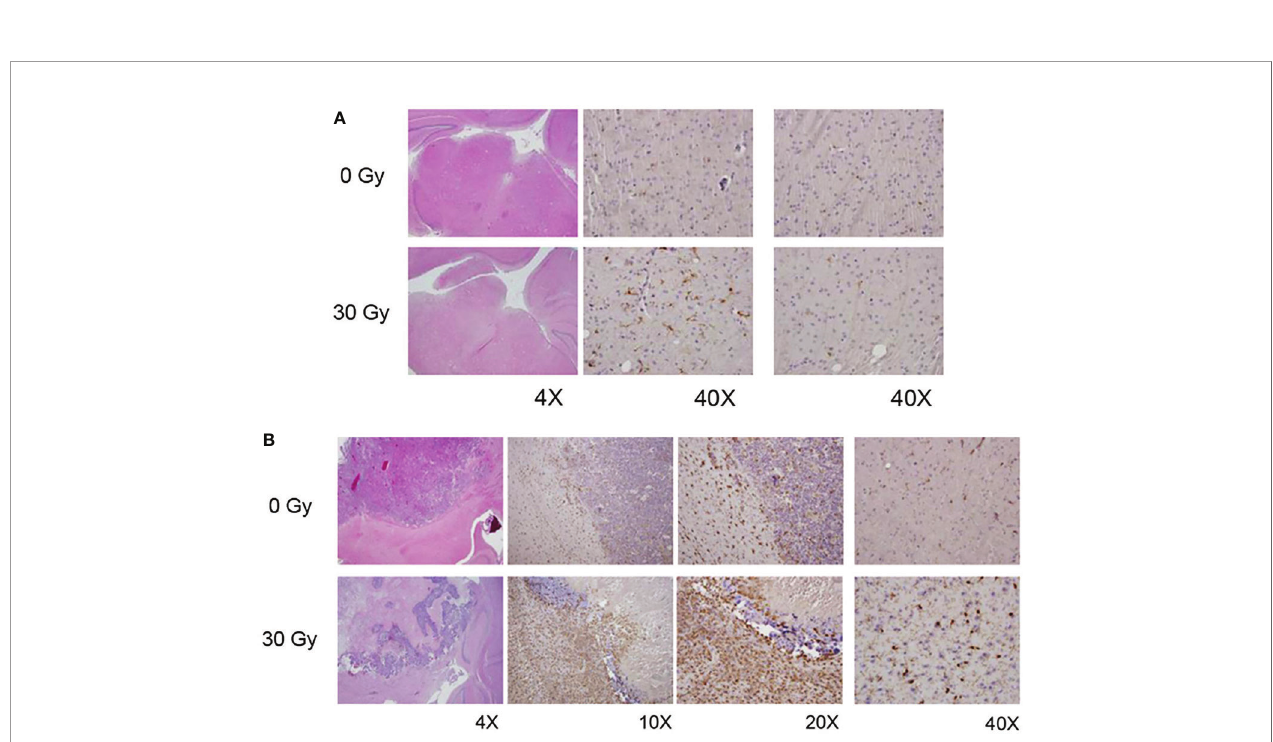
FIGURE 4 | (A) H&E (left column) and IBA1 images (middle, right columns) from non-irradiated (0 Gy; top panel) and focally irradiated (30 Gy; bottom panel) mice in the absence of tumor. Increased IBA1 staining, indicative of increased levels of activated microglia and macrophages, is observed in the irradiated hemisphere, which looks normal by standard H&E staining. (B) H&E (left column) and IBA1 (all other columns) images from non-irradiated (0 Gy; top panel) and irradiated (30 Gy; bottom panel) tumor-bearing mice. Non-irradiated mice generally have well-circumscribed tumor with microglial activation both within the tumor and at its periphery. Tumors implanted into RI 2 M are characterized by large areas of hemorrhage and necrosis with lesser viable tumor. However, there was marked activation of microglia within the tumor and surrounding